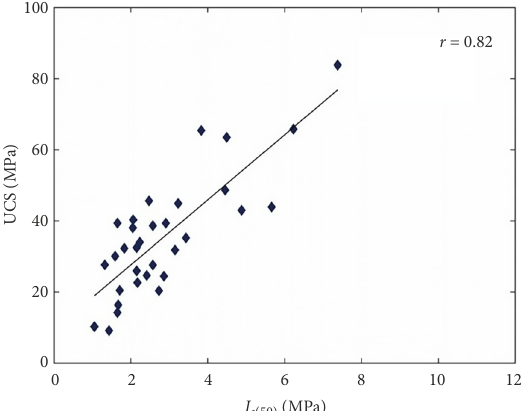
Figure 11. Uniaxial compressive strength (UCS) versus point load strength